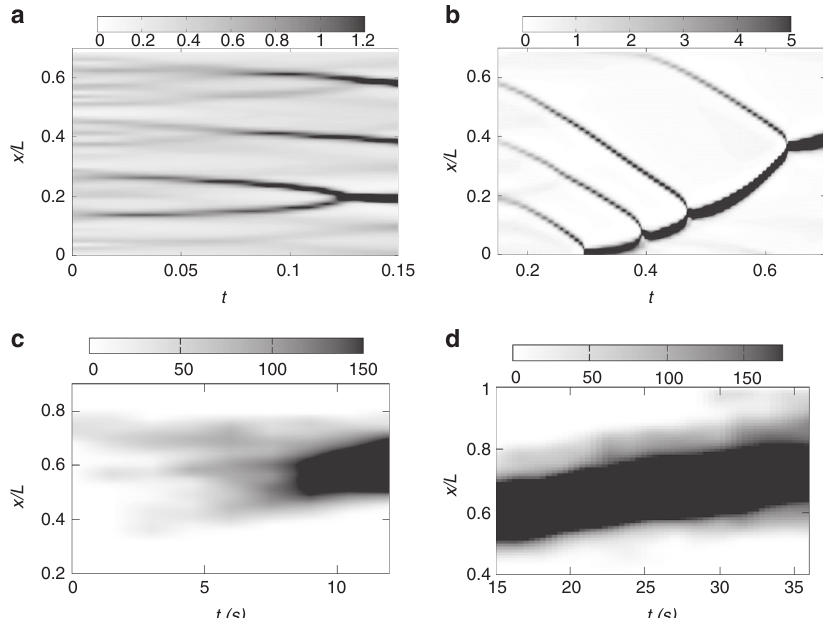
Fig. 3 Kymographs of bound myosin density from theory and experiment: a , b Kymograph of the spatial pro fi le of bound myosin density from theory, shows nucleation and growth (0 < t < 0.15), followed by coalescence (0.15 < t < 0.7) and movement ( t > 0.7). Here B = 6, − ζ 1 Δ μ = 5.5, k = 0.5, α = 1 and D = 0.15. Rest of the parameters as in Fig. 2. c Kymograph of the spatial pro fi le of labeled myosin from experiment, shows nucleation and growth (0 < t < 5 s), followed by coalescence (5 < t < 10 s) and d eventual movement of the formed actomyosin-rich region ( t > 10 s)